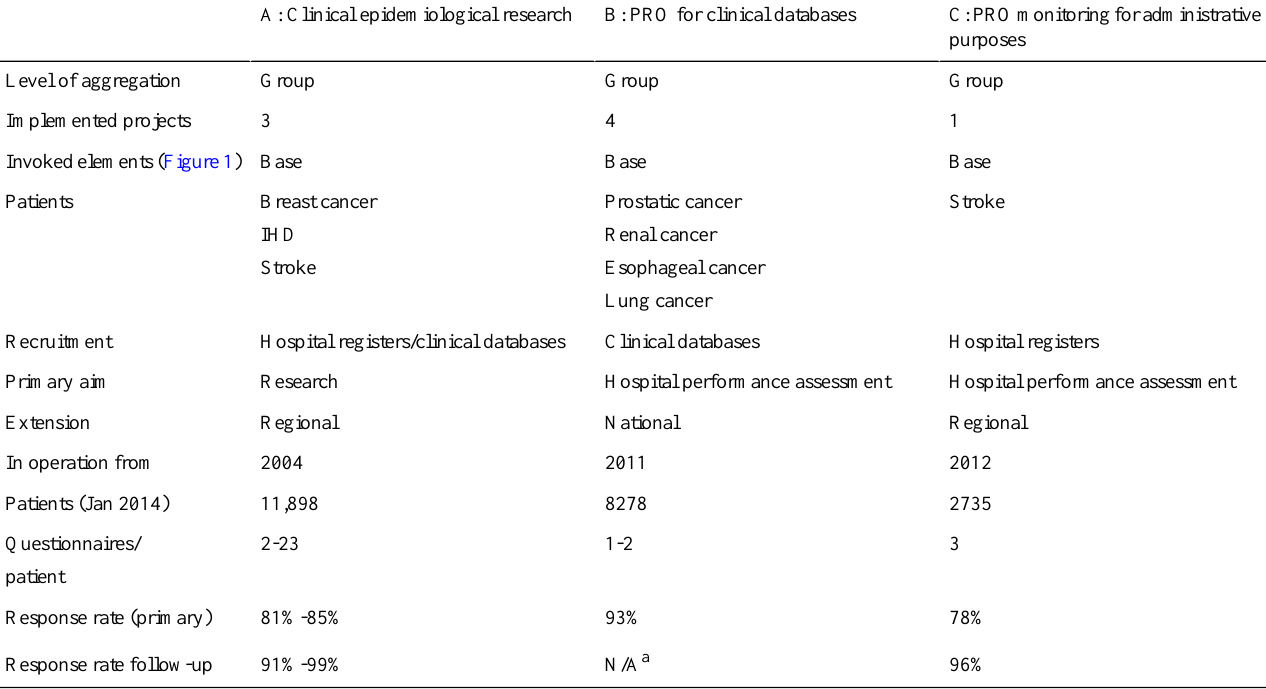
Table 2. Characteristics of 22 projects involving implementations of a generic PRO system. Projects with group level use (n=8).